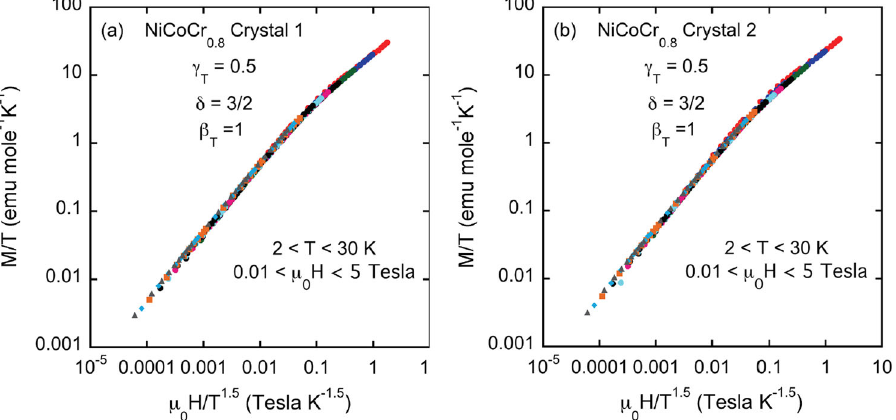
Fig. 5 Demonstration of excellent scaling of magnetization data from two crystals a, b of NiCoCr 0.8 using the experimentally determined values of of γ T ≈ 0.5, and β T ≈ 1. There are no adjustable